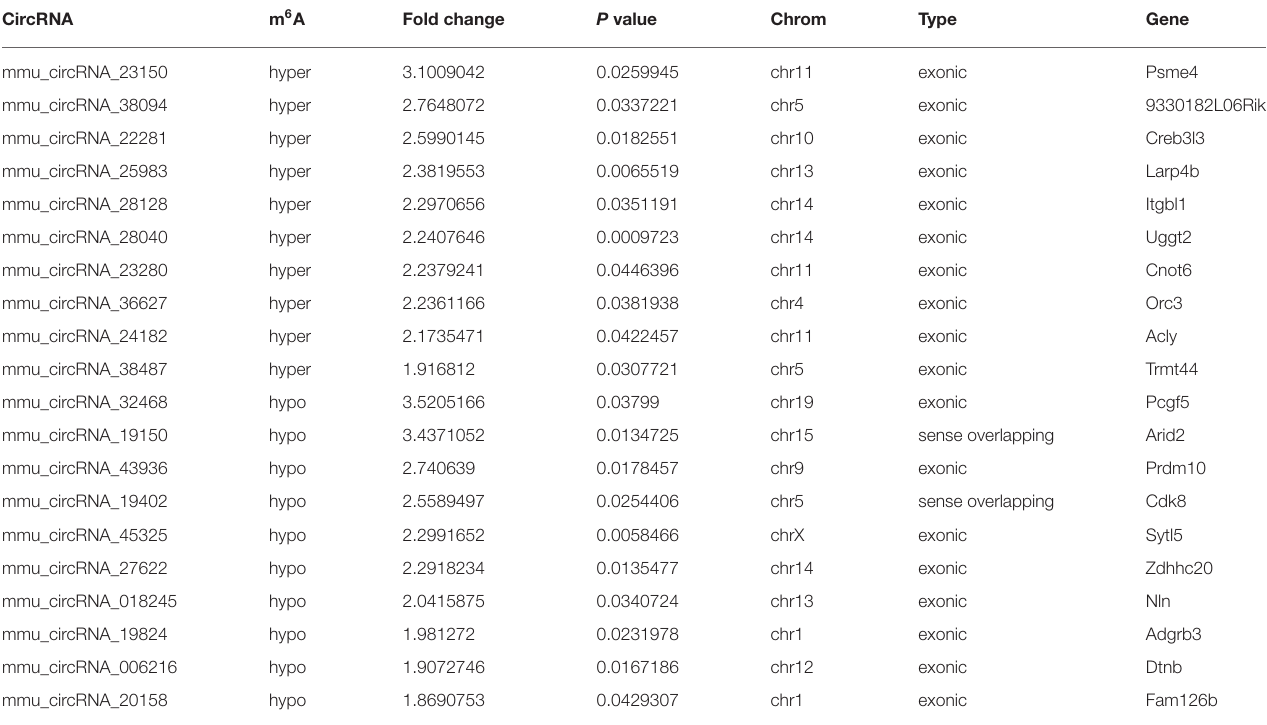
TABLE 3 | The top10 hyper and hypo-methylated circRNAs between 7d vs. sham. CircRNA